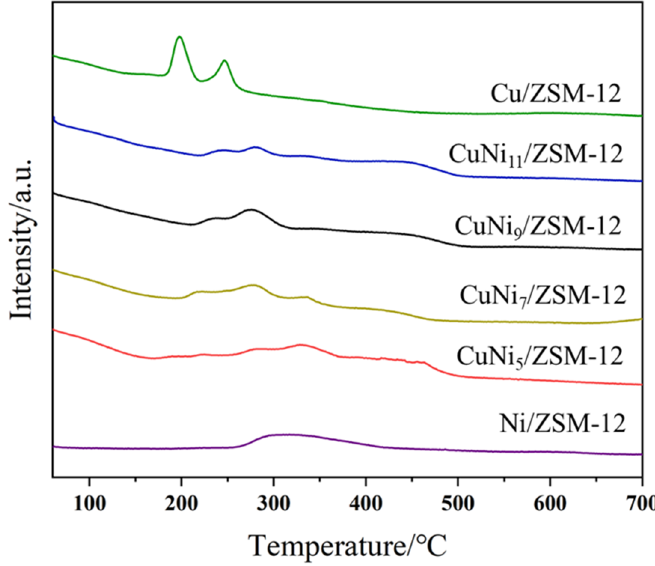
Figure 4. H 2 -TPR results of CuNi x /ZSM-12, Cu/ZSM-12 and Ni/ZSM-12 catalysts.